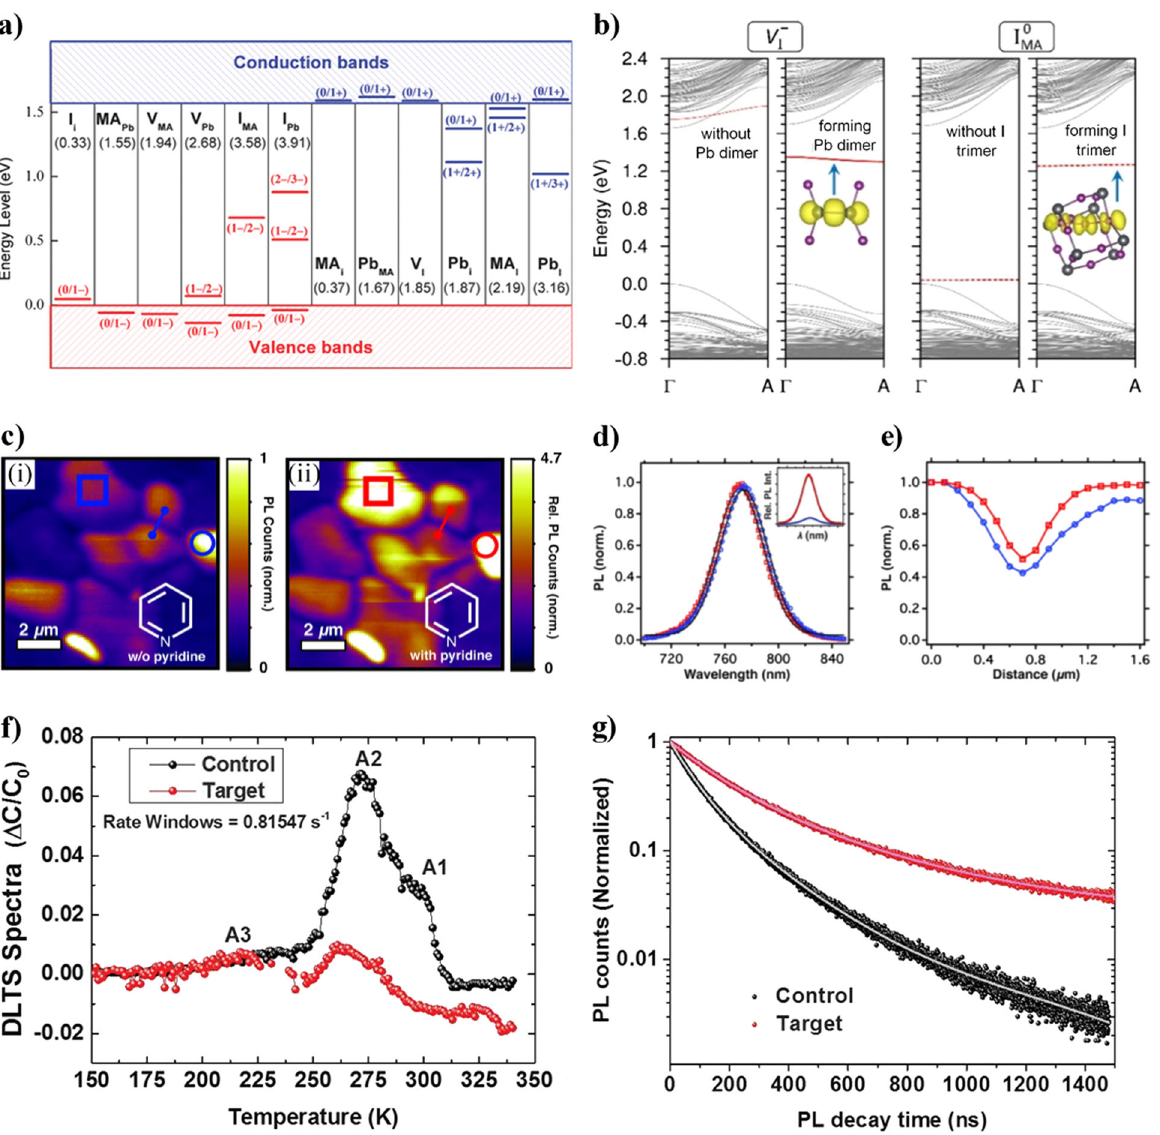
Fig. 1 Defect properties of perovskite fi lms. a Calculated transition energy levels of point defects in CH 3 NH 3 PbI 3 . The formation energies of neutral defects are shown in parentheses. The acceptors/donors are ordered by the formation energies (from left to right). 135 b Band structure plot for the formation of Pb dimer (left) and an I trimer (right) from Γ to (1/2, 1/2, 1/2). 32 c PL images before (i) and after (ii) pyridine treatment showing passivation effect of the CH 3 NH 3 PbI 3 (Cl) fi lm. d , e Bulk steady-state PL spectra showing the relative PL intensities before (blue circle) and after (red square) treatment (inset) and normalized spectra showing a slight blue shift and narrowing of full width at half maximum after treatment. 39 f Deep-level transient spectroscopy (DLTS) spectra of the control (w/o I 3 − ) and target (w I 3 − ) mixed FAPbI 3 -MAPbBr 3 fi lms measured in between 150 and 330 K. 5 g Time-resolved photoluminescence (TRPL) decay curves on the control and target perovskite layers emitted at λ = 825 nm with the biexponential fi tting.